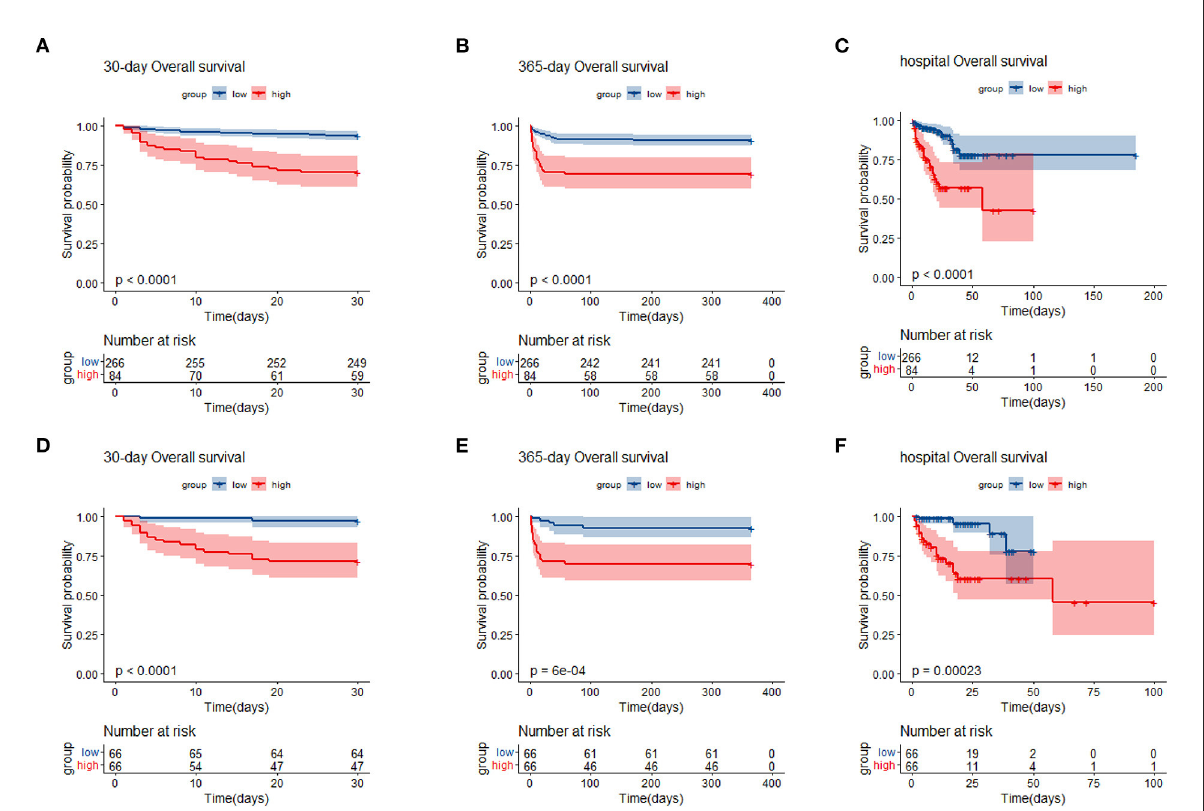
FIGURE3 Kaplan–Meier survival analysis plot for 30-day, 365-day survival and in-hospital in patients before PSM (A–C) , and patients after PSM (D–F) . SIRI, systemic inflammation response index; PSM, propensity score matching; group low ( < 11.24 × 10 9 /L); group high ( ≥ 11.24 × 10 9